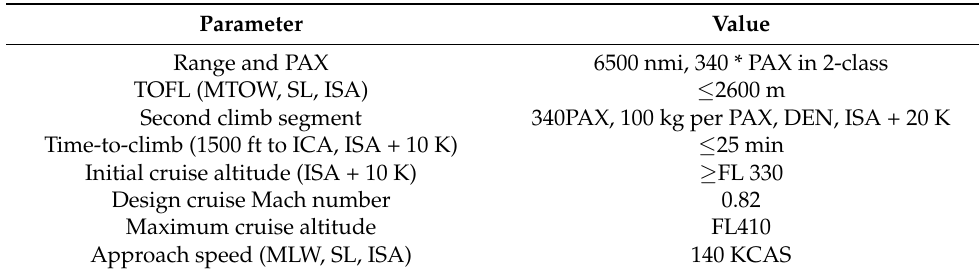
Table 1. CENTRELINE top level aircraft requirements. Parameter Value Range and